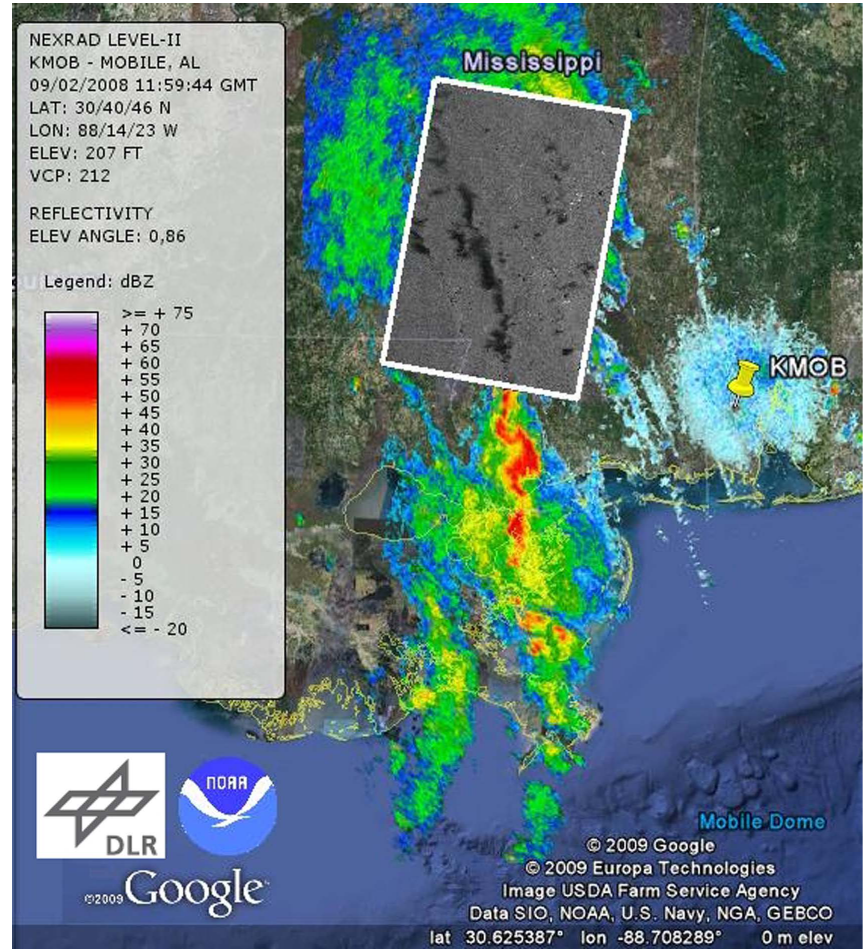
Fig. 3. Geographic representation of the NEXRAD reflectivity plan-position-indicator (PPI, in dBZ) at 0.86 ◦ elevation angle, acquired by the S-band Weather Radar (WR) near Mobile (AL, KMOB in figure) on 2 September 2008, at 12:00UTC. The white bordered box, centered around 30.5 ◦ N × 89.5 ◦ W, represents the scene of interest acquired by TerraSAR-X (TSX) around the same time: within the box a 100m resolution TSX quicklook is placed in arbitrary units. This image has been produced by using NOAA NCDC Weather and Climate Toolkit, TSX preview data and Google Earth software